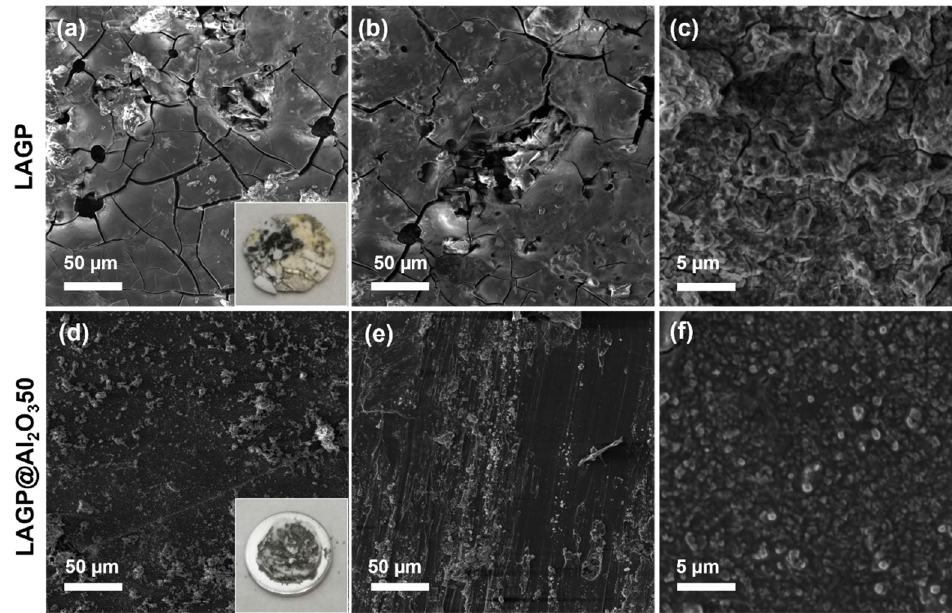
Figure 6. Top-view SEM images of cycled ( a – c ) LAGP and ( d – f ) LAGP@Al 2 O 3 50. The insets of ( a ) and ( d ) show the photos of cycled LAGP and LAGP@Al 2 O 3 50.